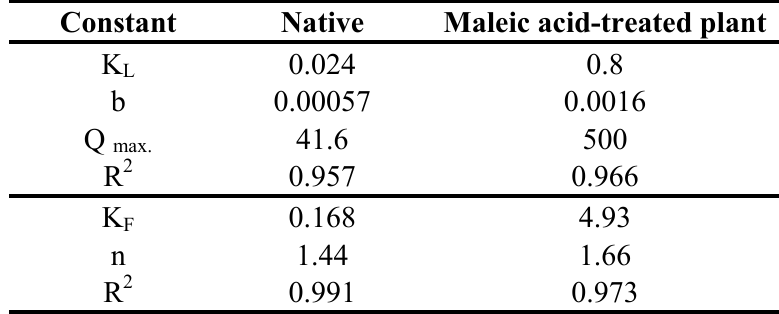
Table 3. Langmuir and Freundlich constants for the adsorption of Cd (II) Ions onto native and maleic acid-treated wastes at pH 4 and 30 